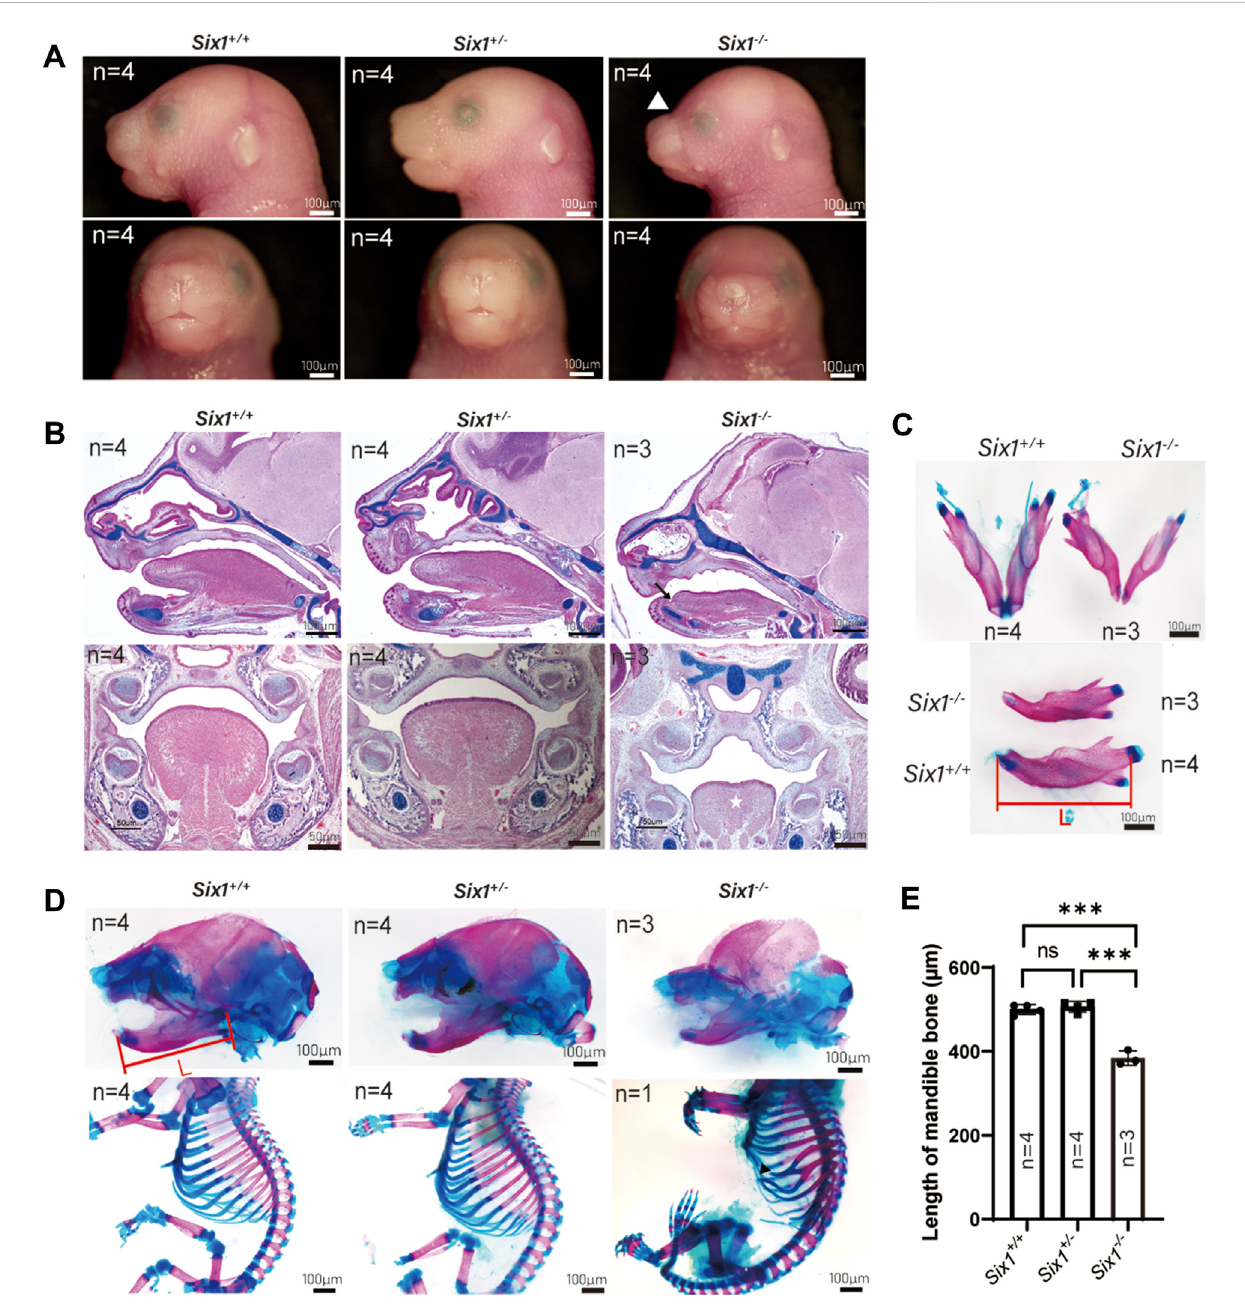
FIGURE 1 The Six1 deletion miceresulted incraniofacial deformity. (A) Lateral view (top)and frontal (bottom) gross morphology ofE18.5headsof the Six1 − / − , Six1 ± and Six1 +/+ embryos. Six1 − / − embryosexhibitshortmandibleandclassicalabnormalcurvebetweennoseandforehead(whitearrowhead). (B) Hematoxylinand eosin(HE)andAlcianbluestainingofsagittalsections(top)andfrontal(bottom)sectionsof Six1 − / − , Six1 +/ − and Six1 +/+ embryoatE16.5. Six1 − / − embryosdisplaya short mandible, ankyloglossia (black arrow), and uvula deformity (white star). (C) Skeletal staining of E18.5 mandible of the Six1 − / − and Six1 +/+ embryo. Six1 − / − miceexhibitashortenedmandible.L: length ofmandible. (D) Skeletalalizarin redandAlcianbluestaining ofE18.5heads(top)and body(bottom) ofthe Six1 − / − , Six1 +/ − and Six1 +/+ embryo. The black arrowhead points to bifurcated ribs. (E) Quanti fi cation of the mandibular length from Six1 − / − , Six1 +/ − and Six1 +/+ embryos at